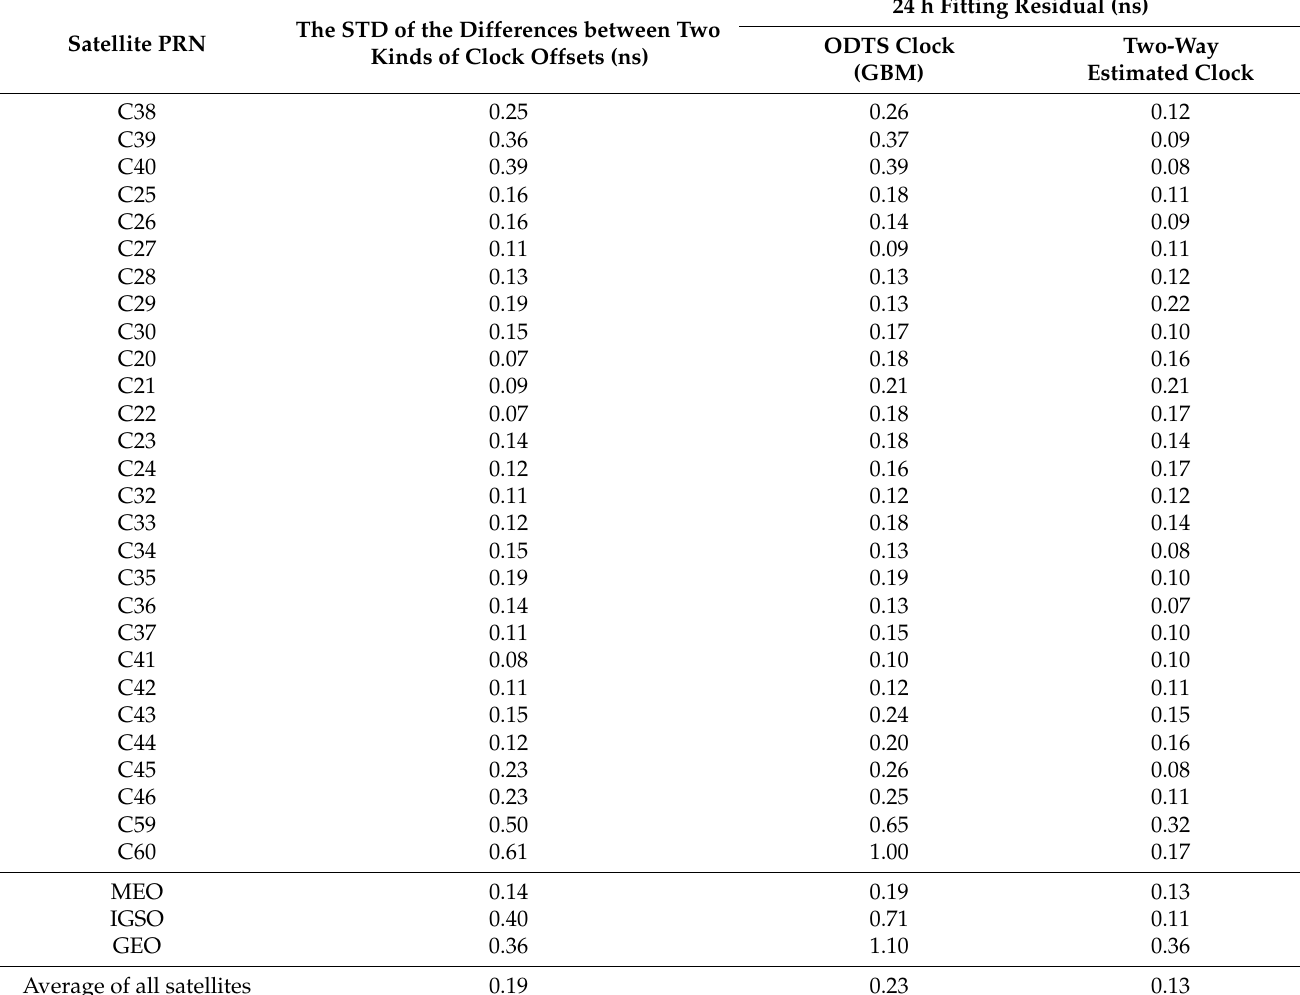
Table 1. Averaging statistical results of the two kinds of 1-day clock offsets